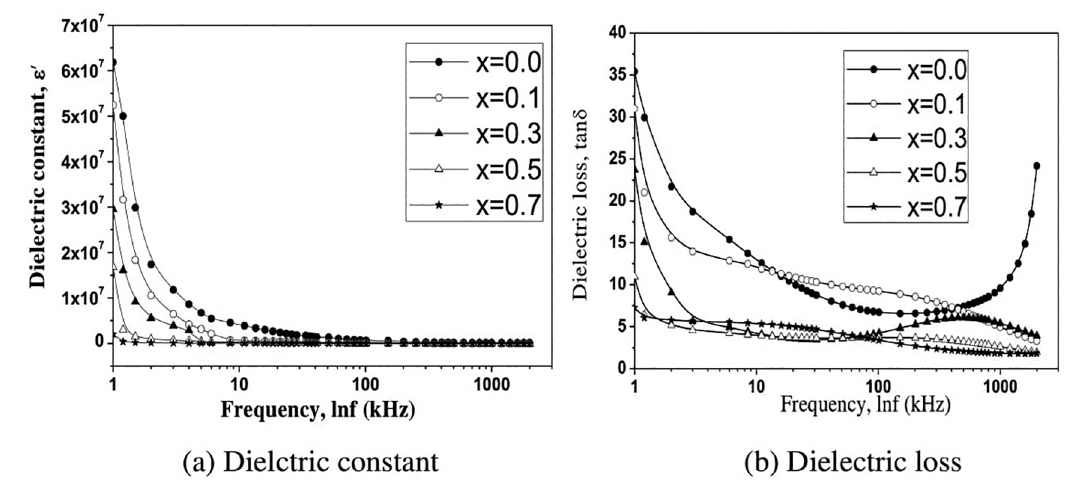
Figure 7. Variation (a) dielectric constant and (b) dielectric loss as a function of frequency. Fe 2+ and Fe 3+ is equal to frequency of the applied field 29